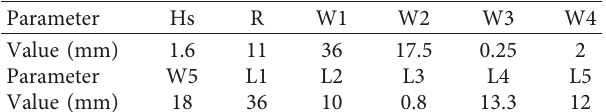
Figure 1: Structure of the (a) planar antenna and (b) cavity-backed antenna. Table 1: Parameter values of the planar antenna.